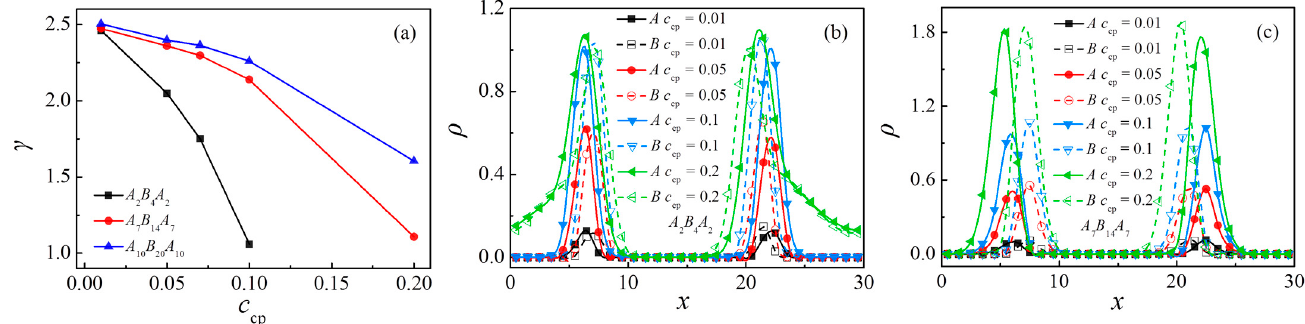
Figure 6. Interfacial tension as a function of triblock copolymer concentration at chain length N cp = 8, 28, 40 ( a ). Density profiles of beads A and B of the triblock copolymer along the x -axis as a function of triblock copolymer concentration at copolymer chain length ( b ) N cp = 8, and ( c ) N cp = 28.